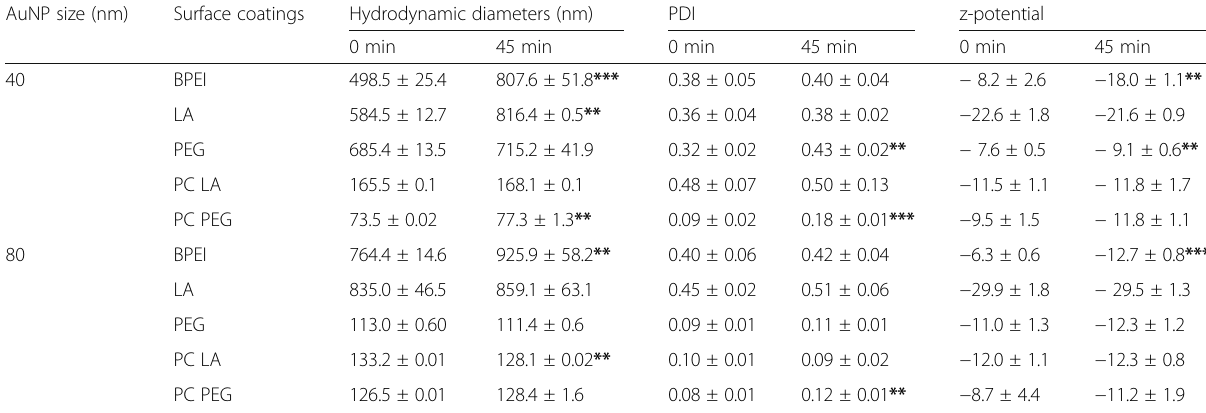
Table 1 Hydrodynamic diameters and polydispersity index (PDI) and zeta (z)-potential of the 40 and 80 nm bare and PC AuNP with cationic BPEI, anionic LA, and neutral PEG in a microsomal incubation buffer (100 mM phosphate buffer) at 0 min and 45 min at 37 °C. Data is mean ± S.D. ( n =